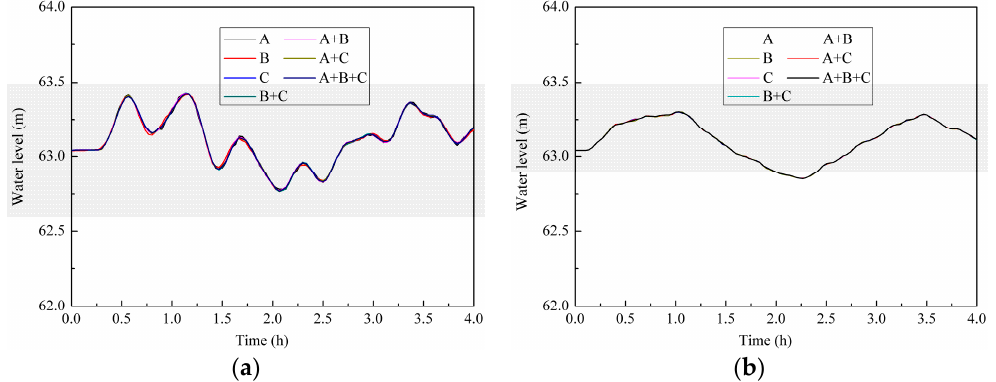
Figure 11. Water level variation process concerning locations of hydropower stations. ( a ) Lower lock head of the ship lift; ( b ) Approach channel entrance.